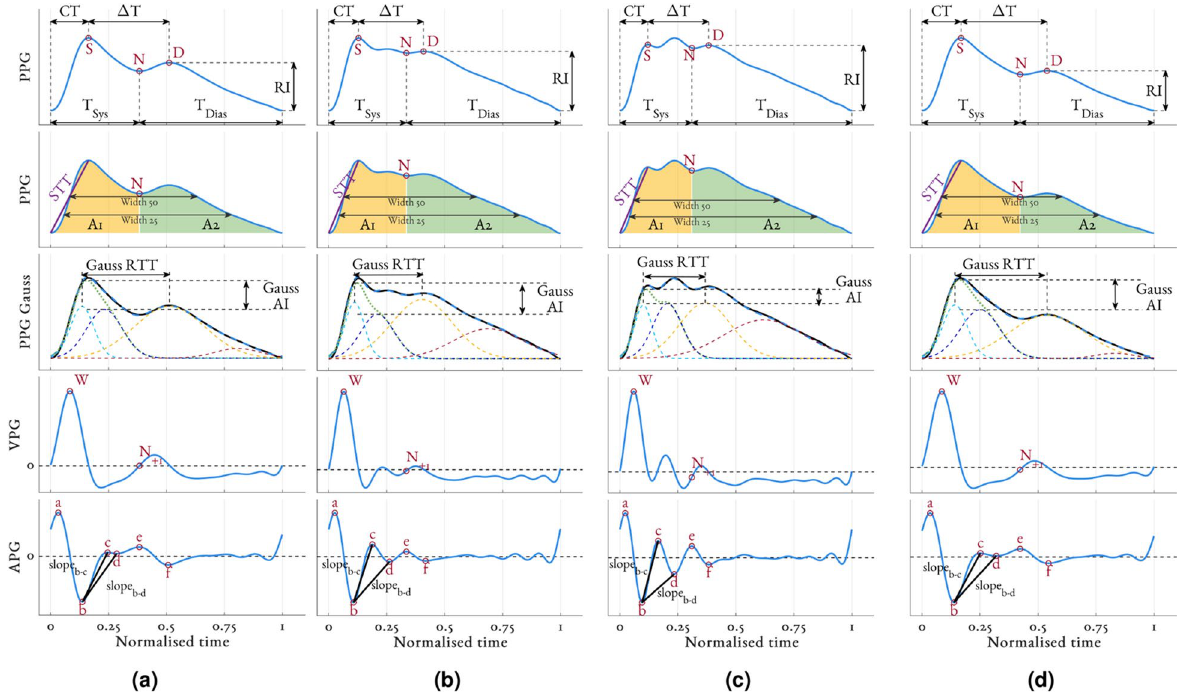
Figure 1. Overview of the fiducial points detected and some of the features extracted from the PPG waveform for one individual (Male, Age: 24, BMI: 25.1) during the four stages of the study protocol: ( a ) rest, ( b ) dose increase, ( c ) maximum infusion, and ( d ) washout. Examples of the following features are provided: Crest time (CT), (cid:31) T, reflection index (RI), width 25 , width 50 , slope transit time (STT), A1, A2, Gaussian estimation of the transit time of the reflected wave (Gauss RTT) and augmentation index (Gauss AI), slope b-c and slope b-d . Acronyms: S - Systolic peak, N - Dicrotic notch, D - Diastolic peak, a-e - waves of the